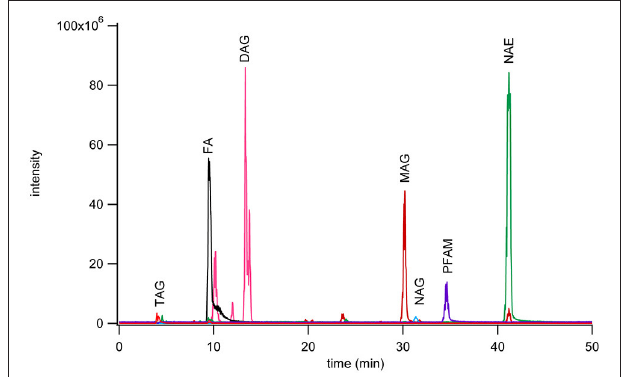
FIGURE 1 | Chromatogram of seven fatty acyl subclasses separated by normal phase chromatography using a YMC PVA-Sil (4.6 ×